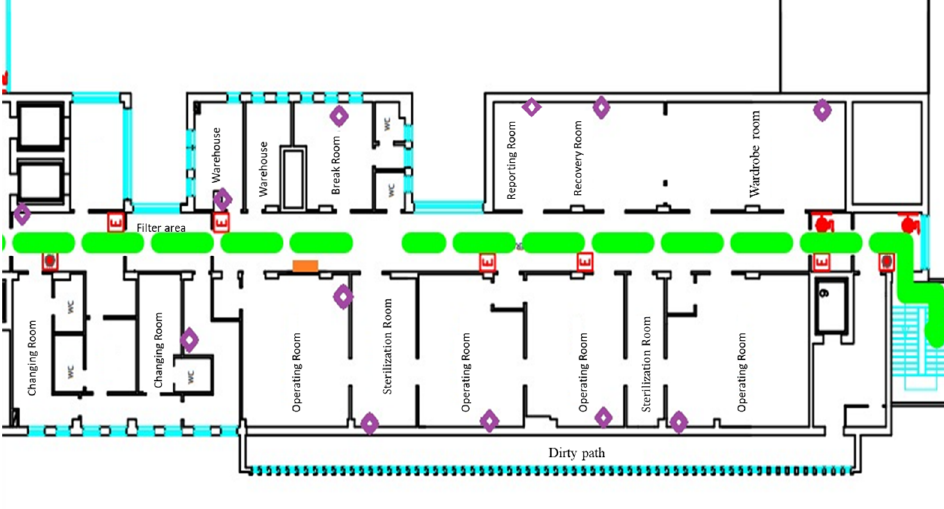
Figure 1. Location of sensors in the OD (Rhombus indicate the EchoBeacon position).